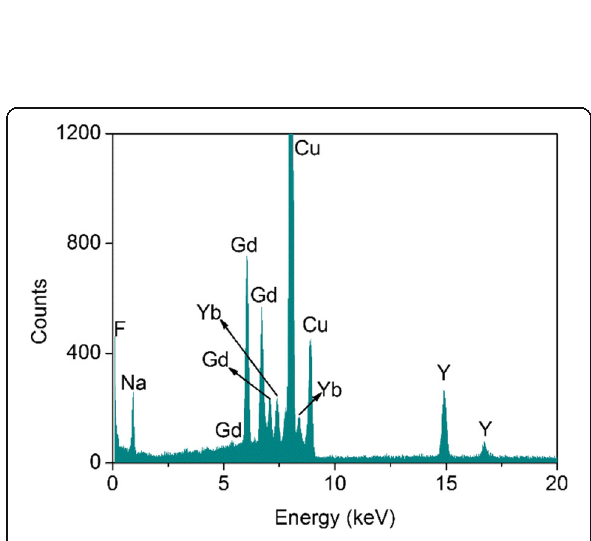
Fig. 5 EDX analysis of elemental composition of heterogeneous NaGdF 4 / NaYF 4 core/shell